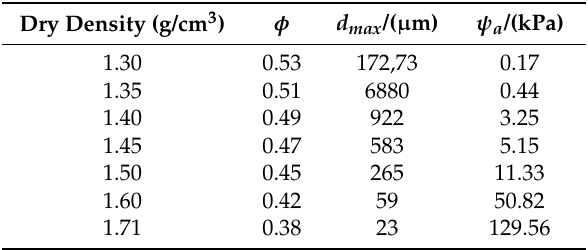
Table 3. Predicted value of φ , d max and Ψ a